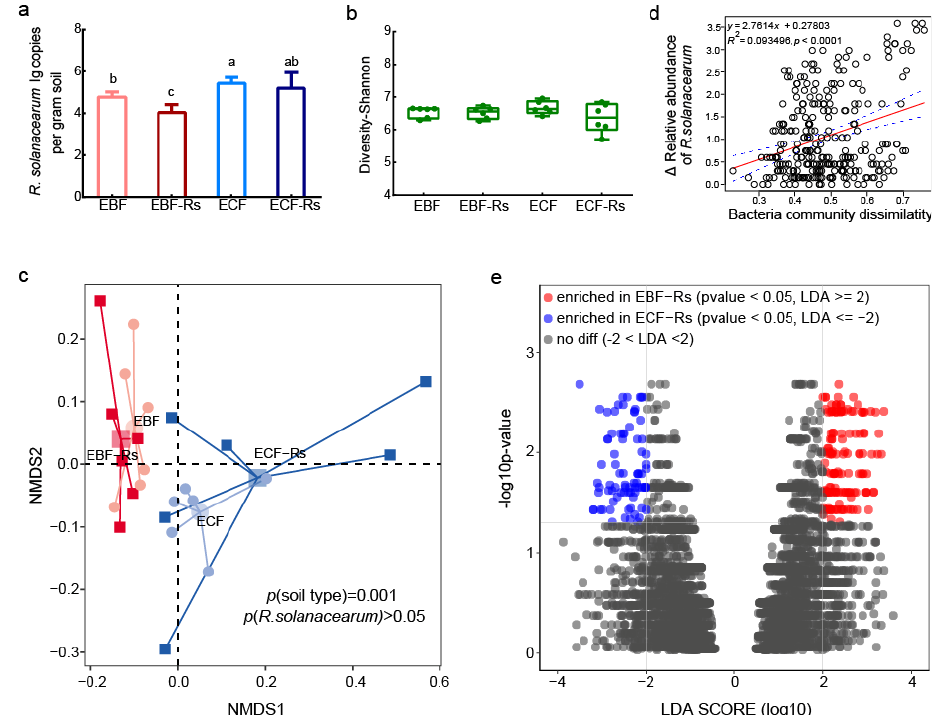
Figure 3. R. solanacearum abundance and bacterial community analysis of Experiment II. ( a ) The abundance of R. solanacearum in the rhizosphere obtained via quantitative PCR; ( b ) Alpha diversity analysis of rhizosphere bacterial communities (Shannon index); ( c ) Non-metric multidimensional scaling (NMDS) and PERMANOVA analysis of rhizosphere bacterial communities; ( d ) Mantel test used to identify the correlation between bacterial communities with relative abundance values of R. solanacearum ; ( e ) LEfSe analysis displaying significant differences in community composition between treatments with pathogen inoculation (LDA ≥ 2 and p < 0.05). EBF: rhizosphere derived from the BF soil without R. solanacearum inoculation; ECF: rhizosphere derived from the CF soil without R. solanacearum inoculation; EBF-Rs: rhizosphere derived from the BF soil and inoculated with R. solanacearum 7 days after the plant establishment in the split-root system; ECF-Rs: rhizosphere derived from the CF soil and inoculated with R. solanacearum 7 days after the plant establishment in the split-root system. Different letters above the bars indicate significant differences at p < 0.05 based on one-way analysis of variance